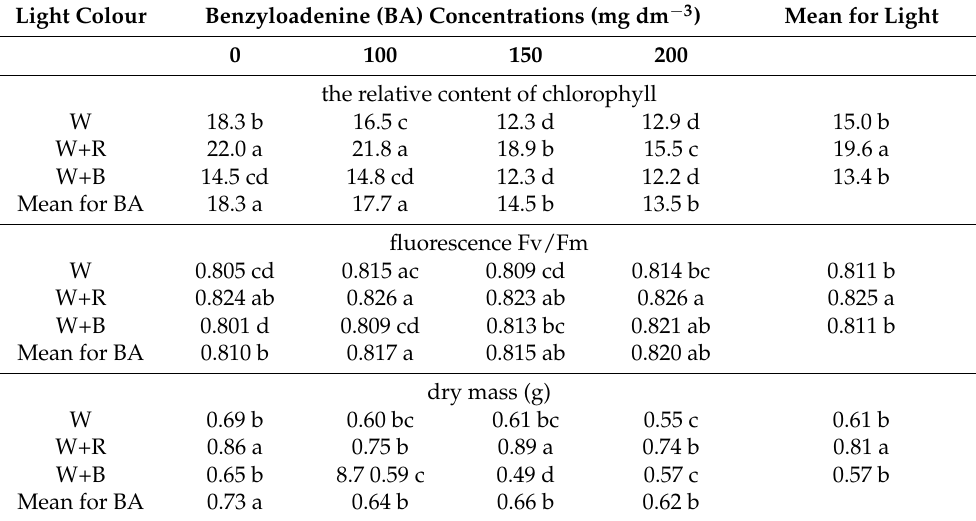
Table 3. Some parameters characterising Calendula officinalis in depending of light colour and benzyladenine concentration.